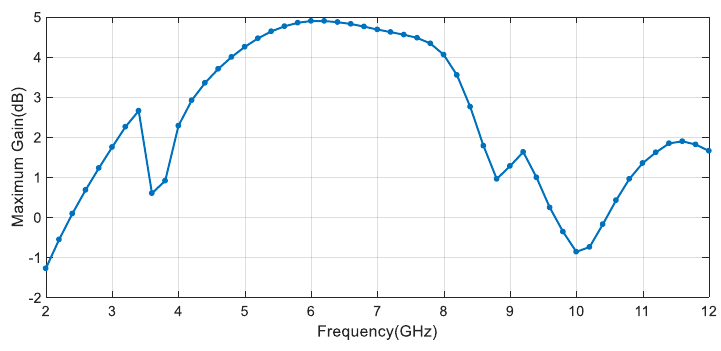
Figure 4. Simulated maximum gain.